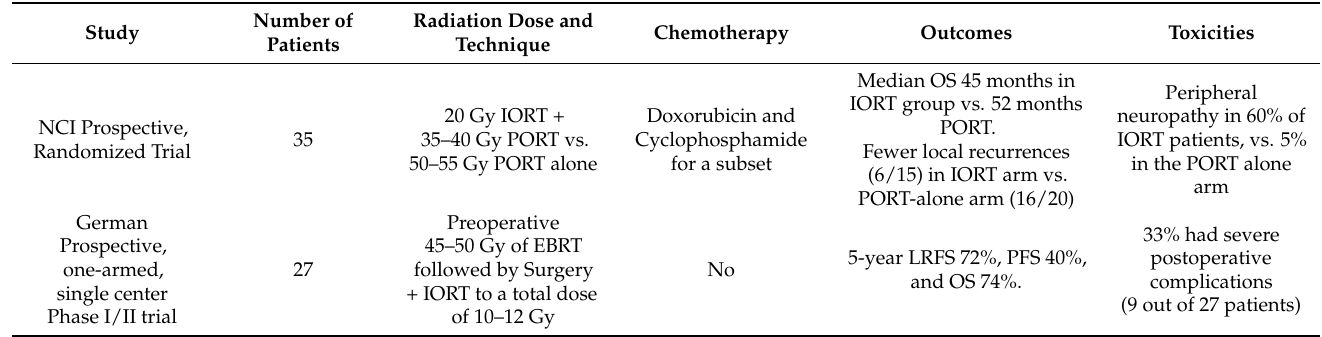
Table 2. Prospective studies evaluating the role of intraoperative radiation therapy (IORT) in the management of